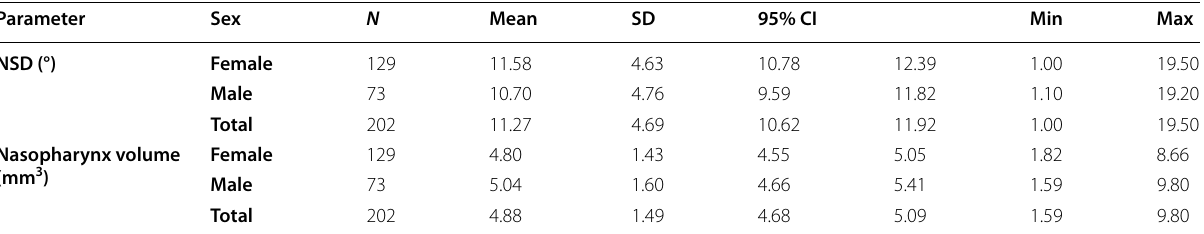
Table 1 Descriptive statistics and 95% CIs for NSD extents (°) and nasopharynx volumes (mm 3 ) in men and women